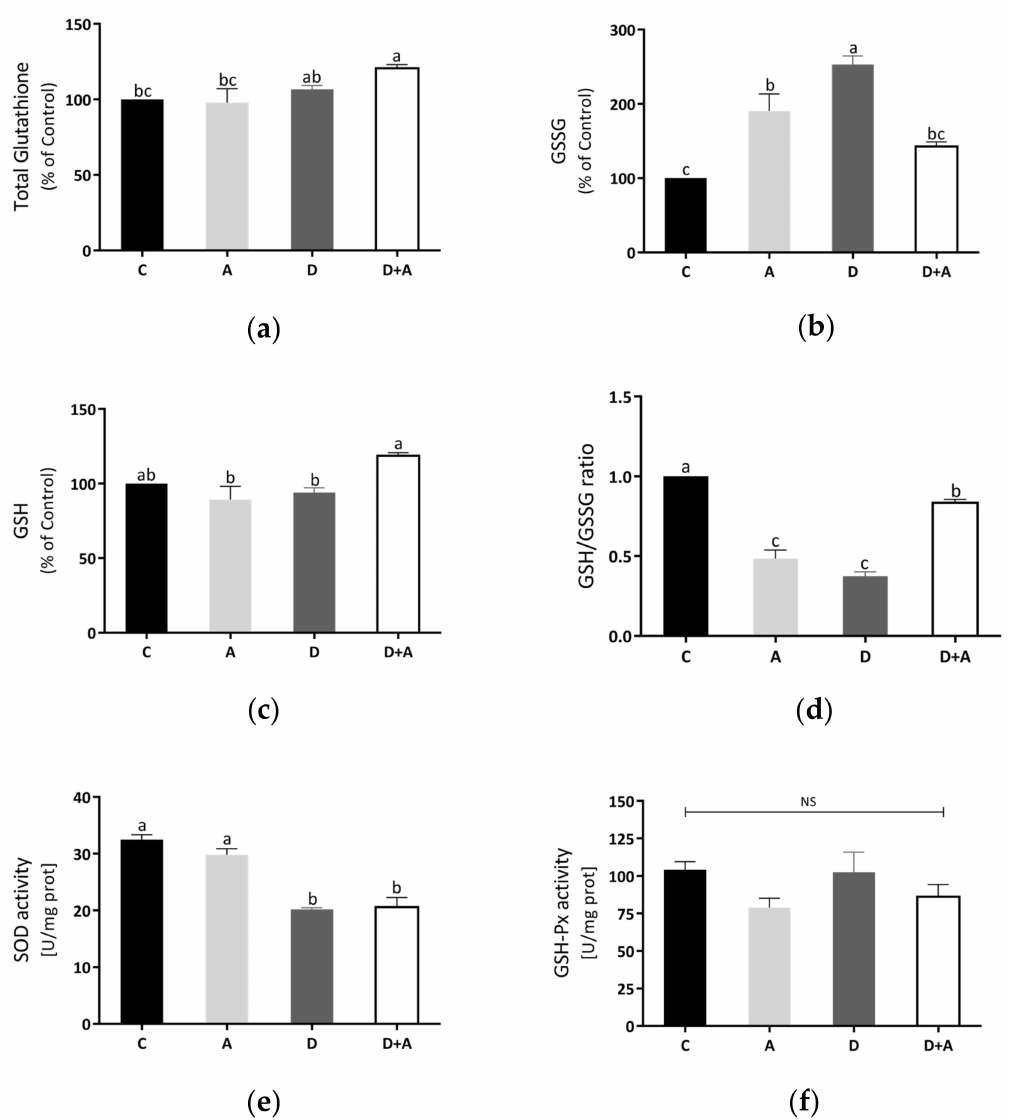
Figure 5. Effect of apocynin on oxidative stress in heart mitochondria. ( a ) Total glutathione. ( b ) Oxidized glutathione. ( c ) Reduced glutathione. ( d ) GSH/GSSG ratio. ( e ) SOD activity. ( f ) GSH-Px activity. Different letters indicate significant differences between groups; ns: Not significant ( p ≤ 0.05) by one-way ANOVA with Tukey post hoc test. Values represent means ± SEM. Control group, C, normoglycemic + apocynin group, A, diabetic group, D, and diabetic + apocynin group,